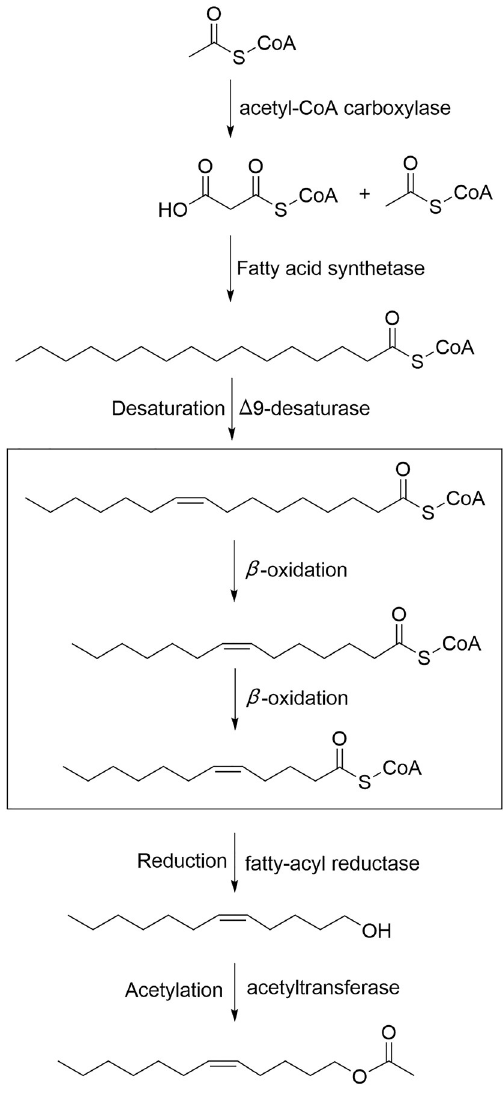
Fig 7. Putative biosynthesis pathway of the sex pheromone component Z5-12:OAc in S . insularis . The saturated fatty acid precursor palmitic acid (16:0) is desaturated by Δ 9-desaturase to form the precursor Z9-16:acyl-CoA in the production of the minor pheromone component